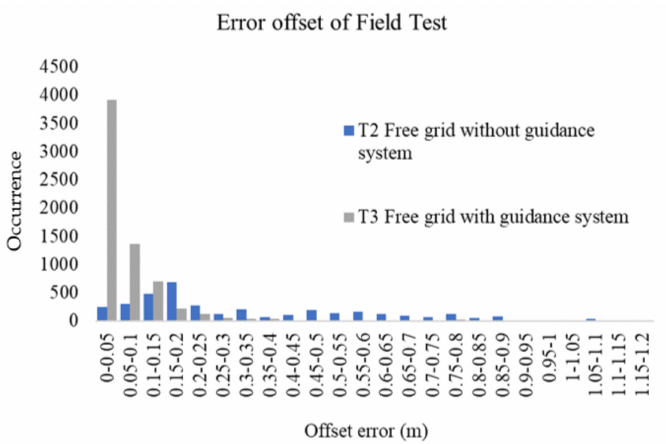
Figure 12. Distribution of offset errors from two paths on the site test.